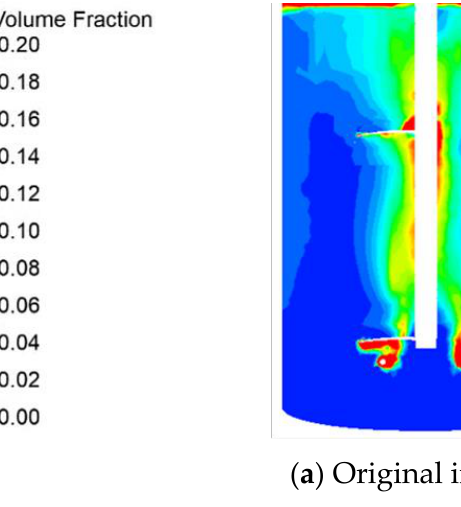
Figure 8. Gas distribution under different impeller type combinations under 125 rpm.